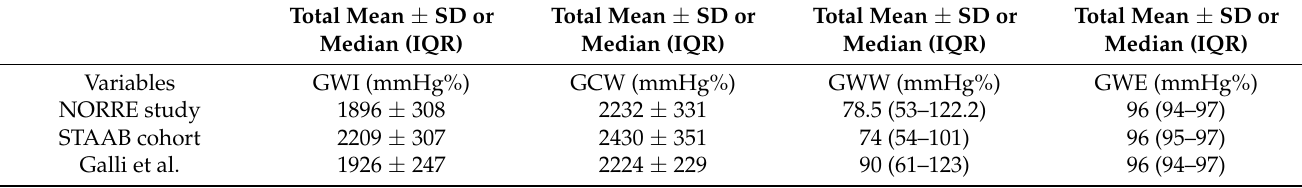
Table 2. Reference values in healthy subjects according to three different